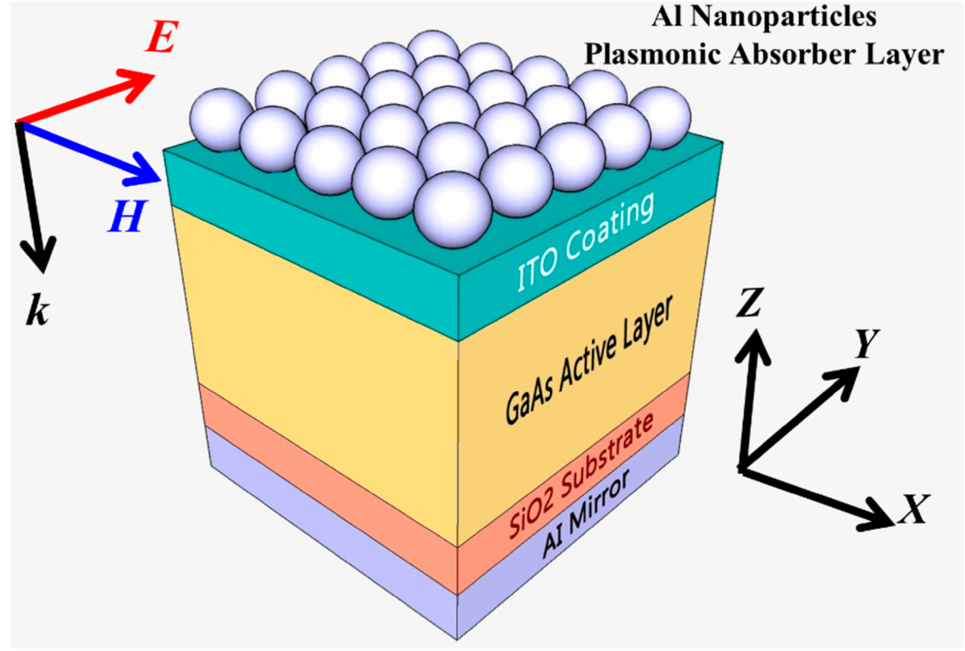
Figure 1. A schematic diagram of thin film GaAs solar cells having Al nanoparticle array placed both on top